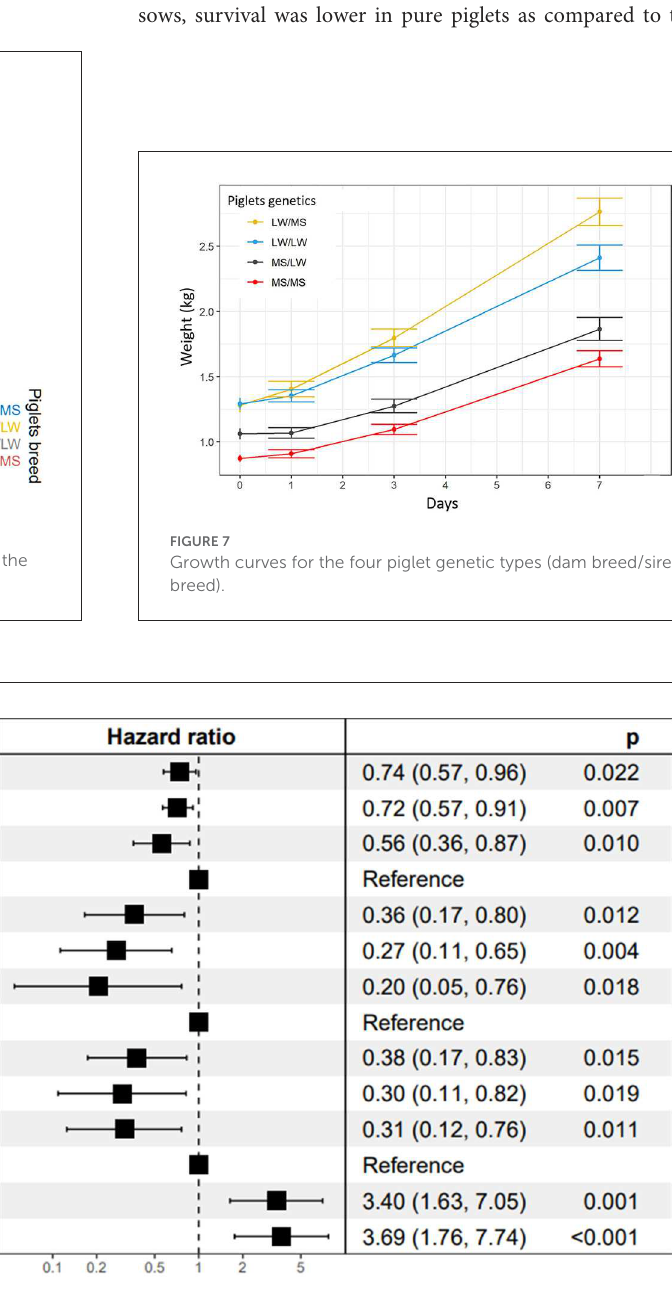
FIGURE6 Estimates of Hazard ratios from the Cox model. “Something other D-1” is the time spent doing something other while standing, LLU D1–D7 is the time spent lying with the udder exposed after farrowing and PCAll D1–D7 is the average number of postural changes per day after farrowing divided by 100. The abbreviation for piglet genetic types is dam breed/sire breed. The four pens A, B, C, and D correspond to the location from the maternity entrance, A is the nearest, and D the farthest. For Litter Size, I represents the inferior quartile and S the superior